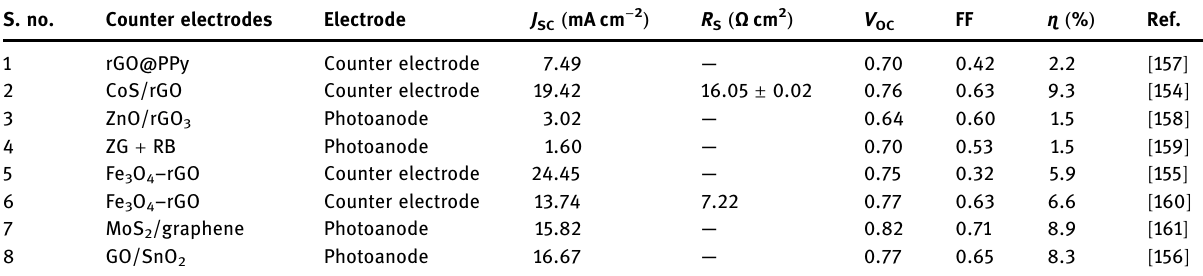
Table 1: Comparison of the various parameters of photovoltaic properties of functionalized graphene nanocomposites S. no. Counter